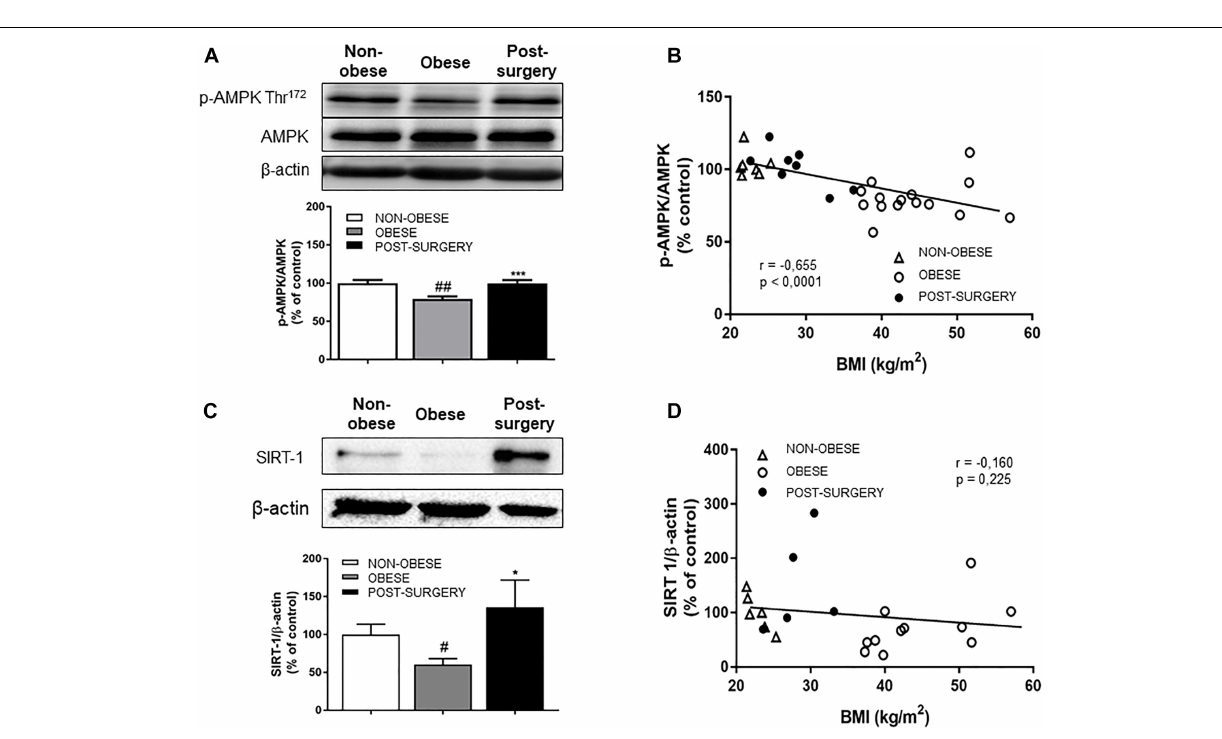
Frontiers in Physiology |